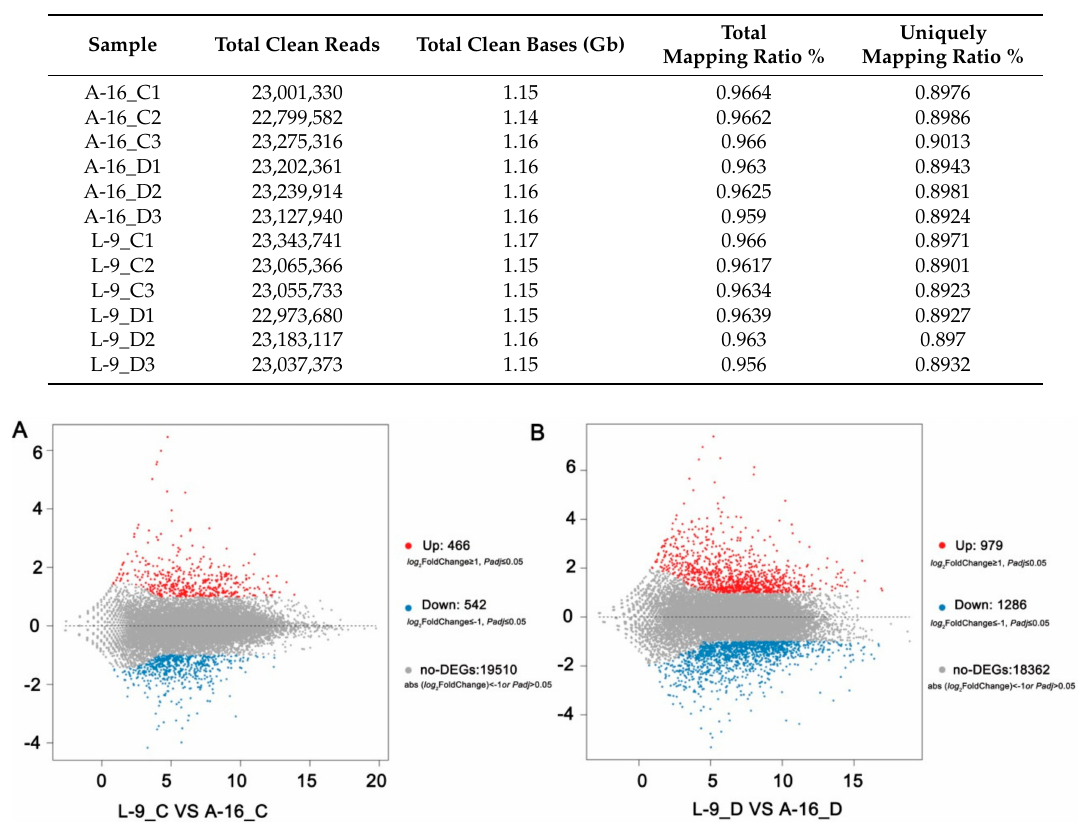
Table 1. Mapping results of RNA sequencing reads of the cucumber between L-9 and A-16 under normal condition (C) and 4 days after drought (D).